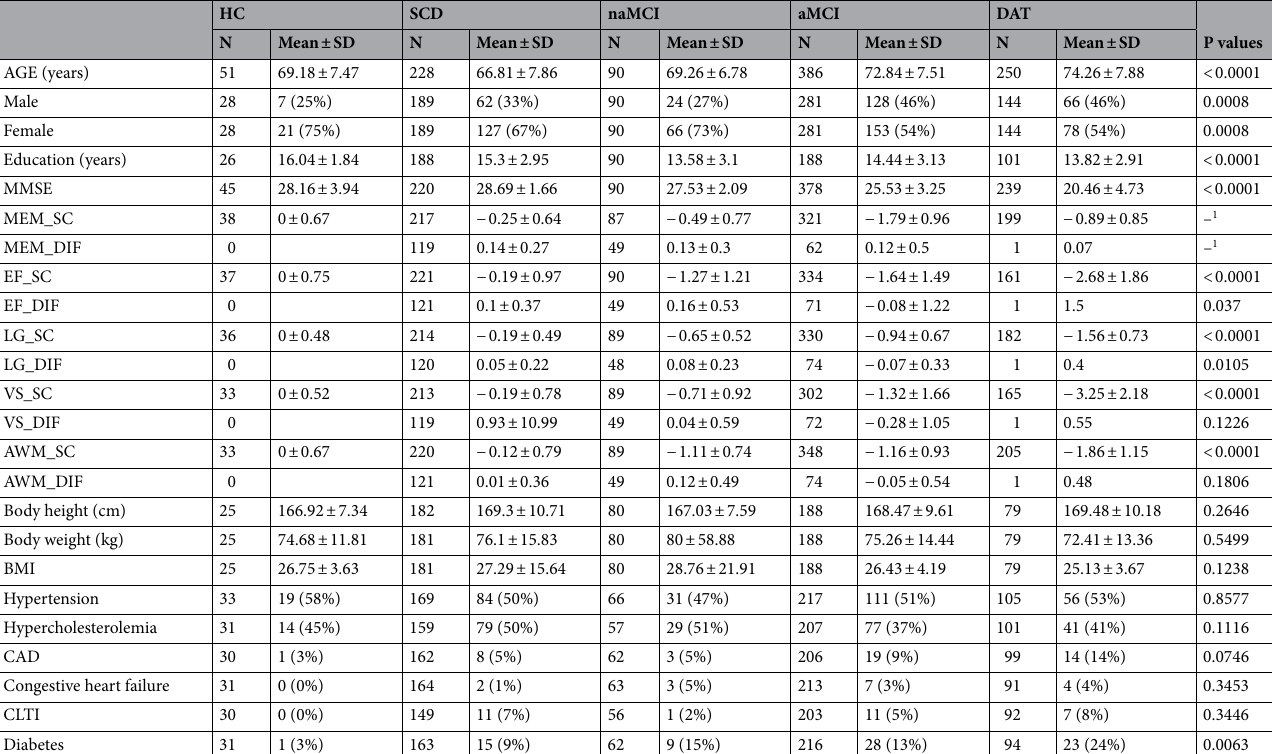
Table 1. Descriptive statistics. 1 z-scores are not comparable between groups because different cognitive